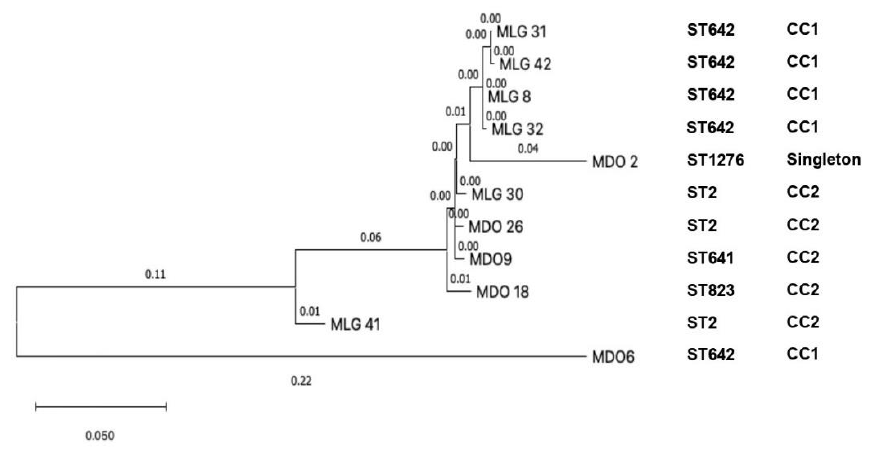
Figure 5. The phylogenetic tree of eleven clinical CRAb-cc isolates in Indonesia (MLG = Malang; MDO = Manado).